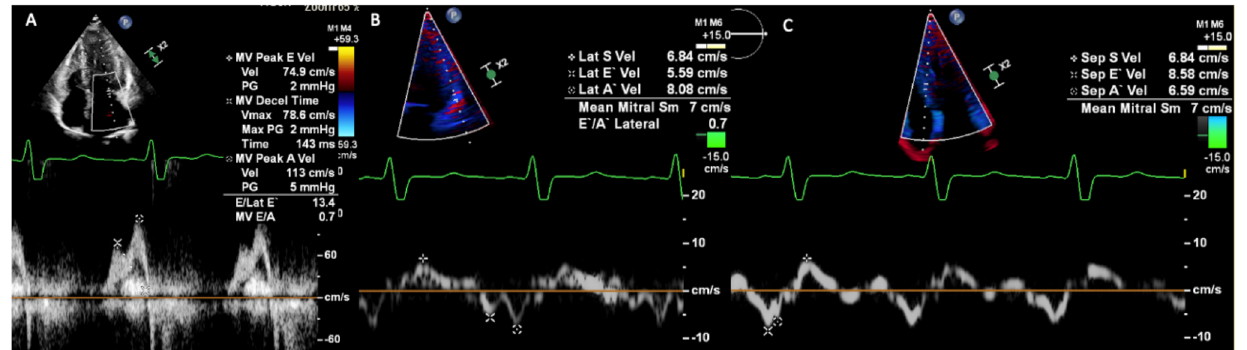
Figure 4. Pulsed-wave Doppler and TDI TTE in a patient with Fabry cardiomyopathy. ( A ): Pulsed- wave Doppler through the mitral valve leaflets showing E/A 0.7 and deceleration time 143 ms with LA dilatation; ( B ): Lateral TDI showing reduced lateral s’ and e’ velocities; ( C ): Septal TDI showing reduced septal s’ and e’